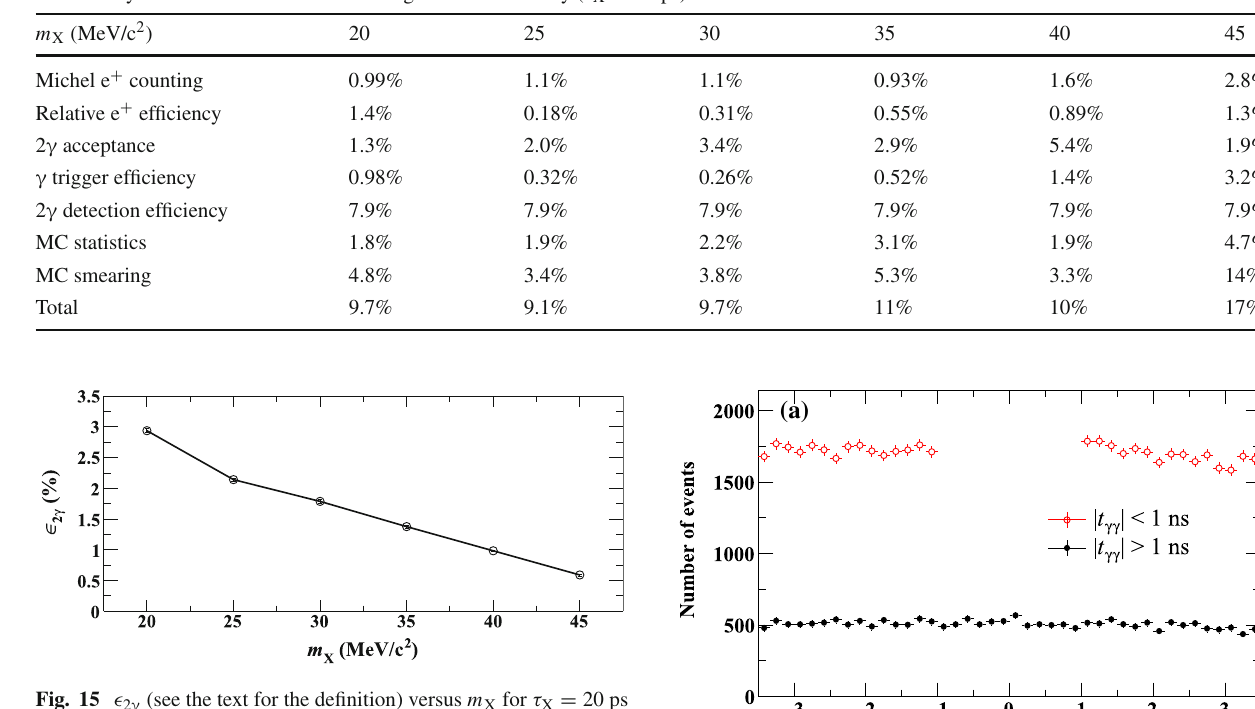
Table 1 Systematic uncertainties in the single event sensitivity ( τ X = 20 ps)